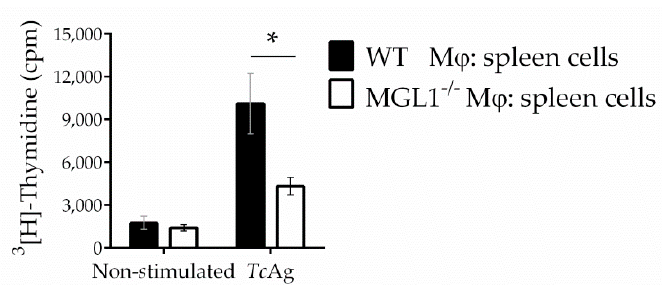
Figure 5. MGL1 − / − PE-M φ induce a deficient activation of T. cruzi antigen-specific lymphocytes. PE-M φ from MGL1 − / − or WT mice were stimulated with TcAg, two hours later M φ were washed to remove the non-phagocytosed antigen. Splenocytes from 21 days-infected WT mice were added at ratio of 1:10. After 5 days, cell proliferation was assessed by [ 3 H]thymidine incorporation. Data are representative of three separate experiments and are plotted as the means of triplicate wells ( ± SEM), n = 7, * p < 0.05.